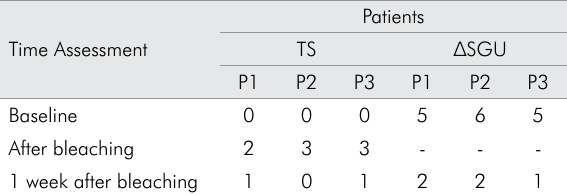
Table 1. TS scores and SGU at different assessment points for each participant.